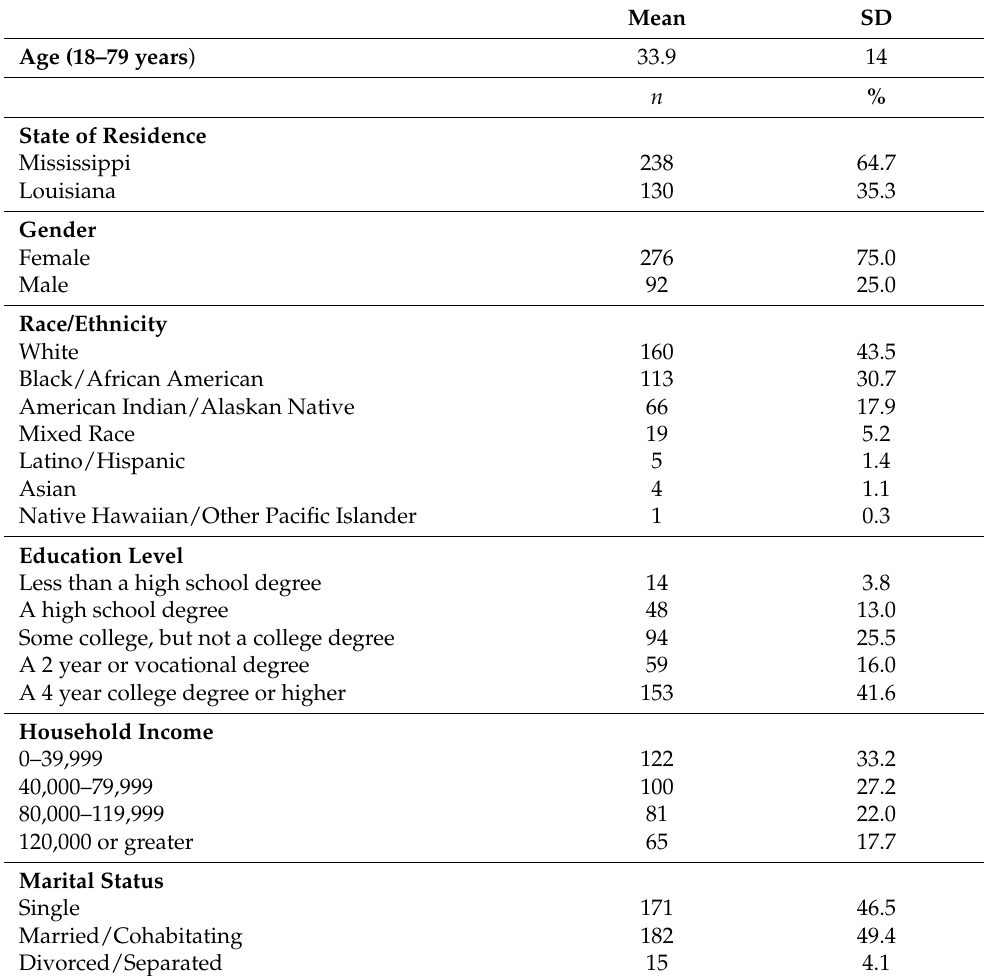
Table 1. Demographic characteristics of the sample ( n =